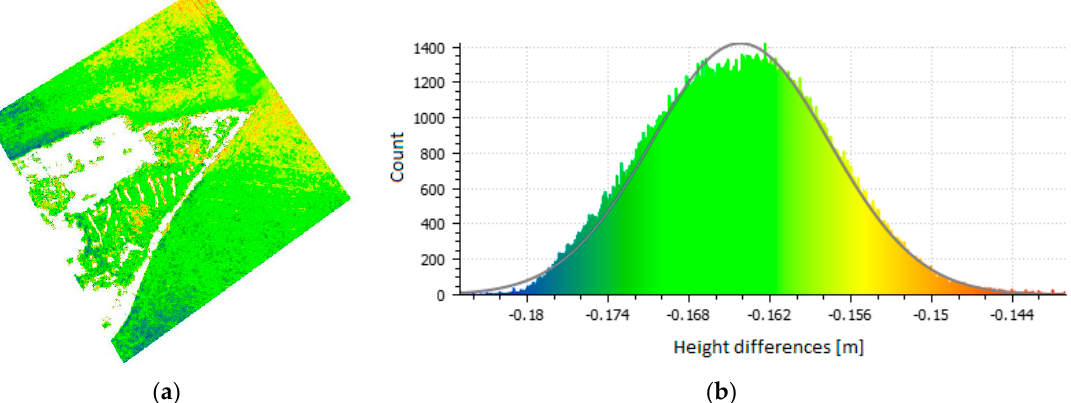
Figure 8. Point cloud comparison ( a ) (Combined vs. RTK, Rural area, Flight 1, and vertical deviations) and the histogram of errors ( b ).